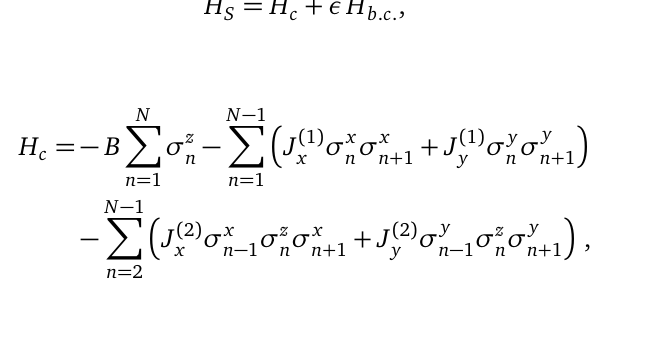
Figure 2: Chain of interacting spins. The nearest neighbor interaction couples two neighboring spins in the x - and y -component with coupling constants J ( 1 ) lines). The three-body interaction (blue lines) with coupling constants J ( 2 ) involves the x - and y - components of two next nearest neighbor spins at position n − 1 and n + 1, and the z -component of the intermediate spin at position n